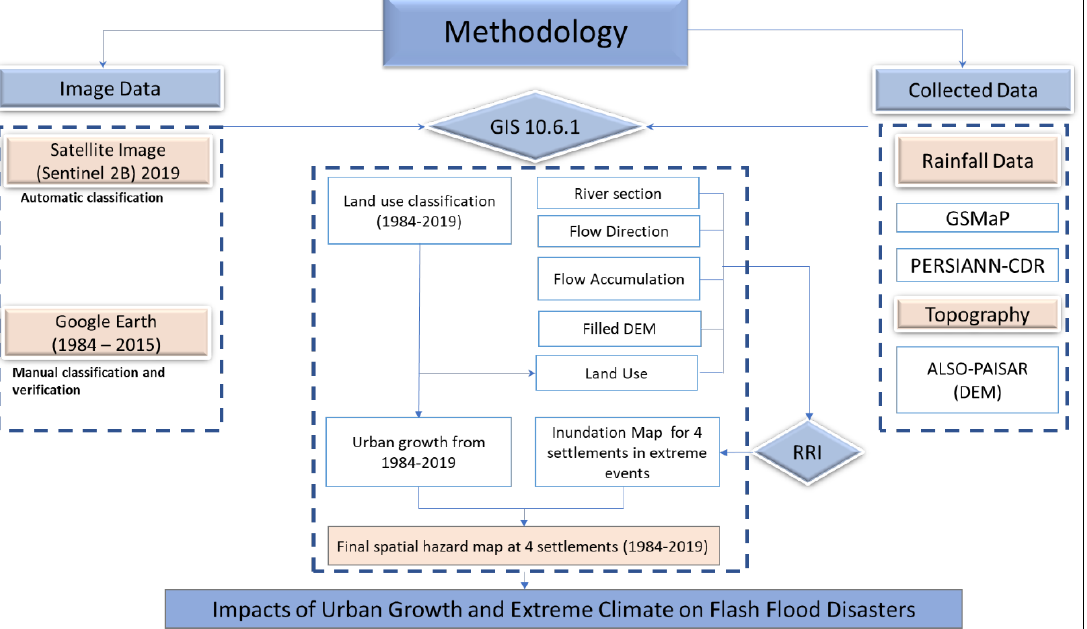
Figure 5. Flow chart for the data processing and methods.